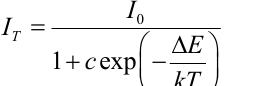
Fig. 13 Arrhenius fitting of the emission intensity of Ba 0.79 Al 10.9 O 17.14 :0.04Eu,0.04Li + and the calculated activation energy (Δ E ) for thermal model. The critical quenching concentration of Eu 2+ in Al O : x Eu ( x = 0.005–0.12) is about 2 mol%, Ba 0.79 10.9 17.14 which is verified to be the dipole–dipole interaction. The colors of phosphors can be easily tuned from blue (0.23, 0.10) to red (0.42, 0.27) by adjusting the valance state through controlling the concentration of Li + , and the emission intensity maintains at a high level with 70.73% at 150 ℃ compared with the intensity at room temperature.